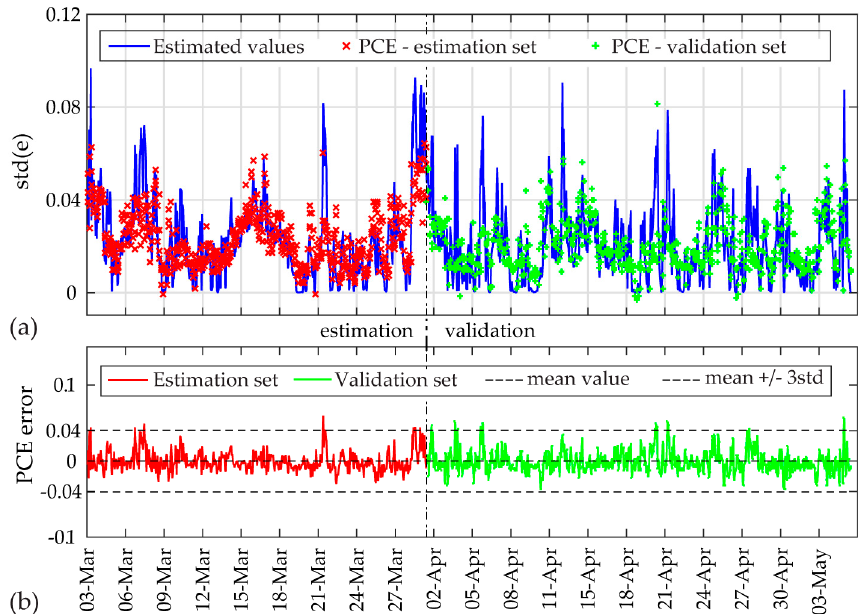
Figure 16. PCE estimates for Case A: ( a ) std of SP-TARMA(32,32,1,0.01) model residual and PCE model expansion values; ( b ) The PCE errors along with 99.7% confidence intervals (calculated for estimation set).